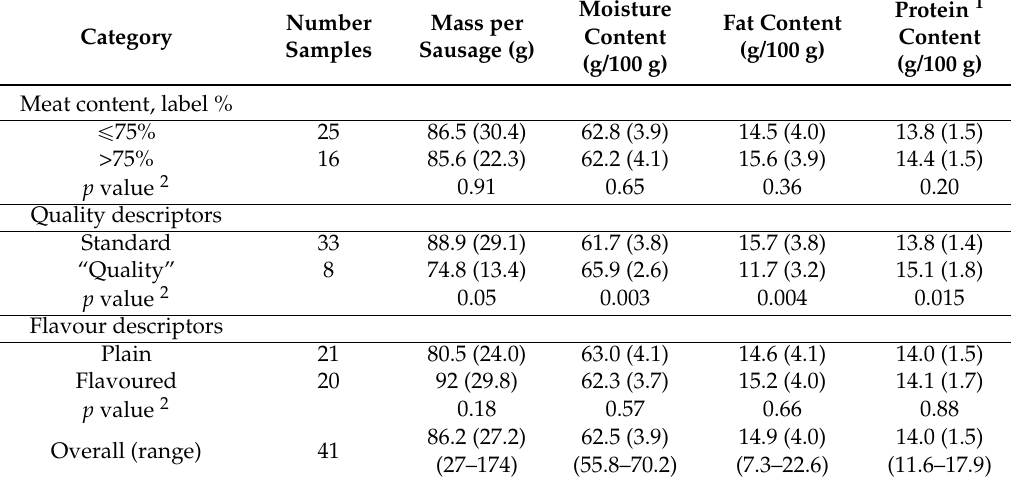
Table 2. Moisture, fat and protein contents (mean (standard deviation)) of raw beef sausages according to purchase location, labelled meat content and label